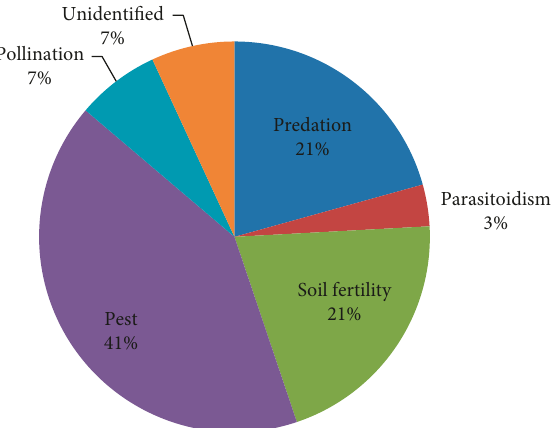
Figure 5: Proportion of potential ecological role of the organisms recorded. Table 4: Relative abundance (%) of key species collected from sweep net and soil litter on different land-use systems. Land use